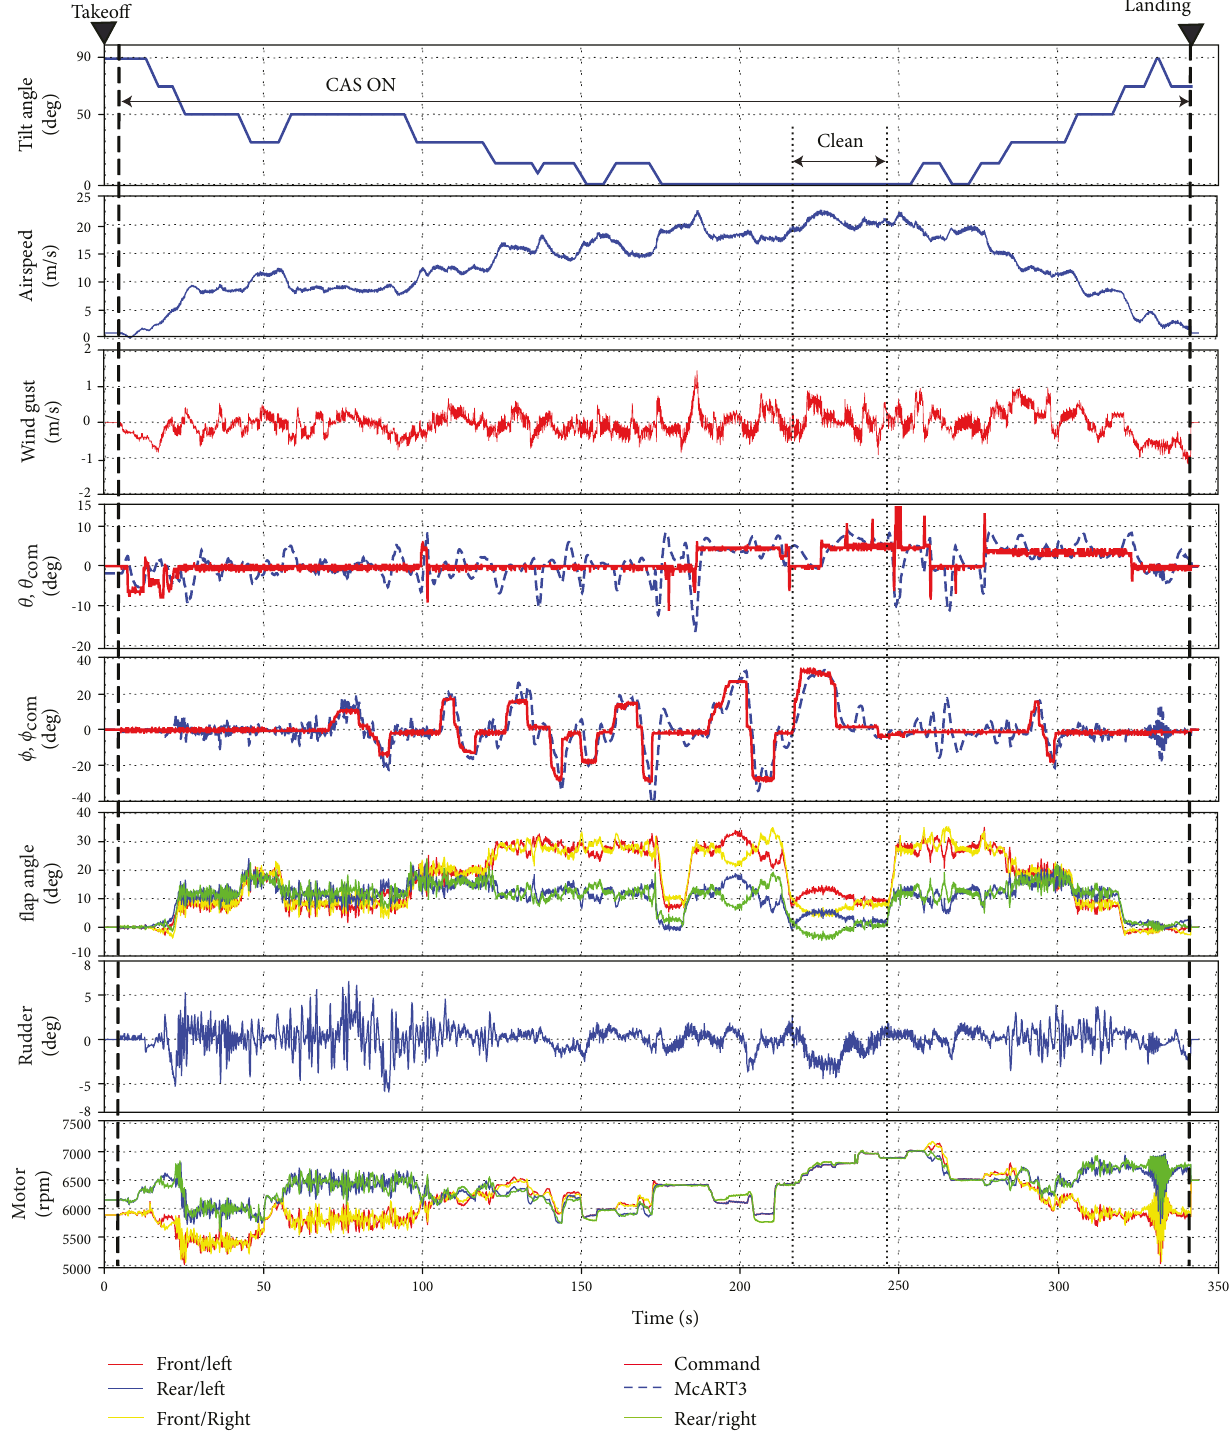
Figure 11: Time history of human – in – the – loop fl ight simulation under gusty condition using Dryden